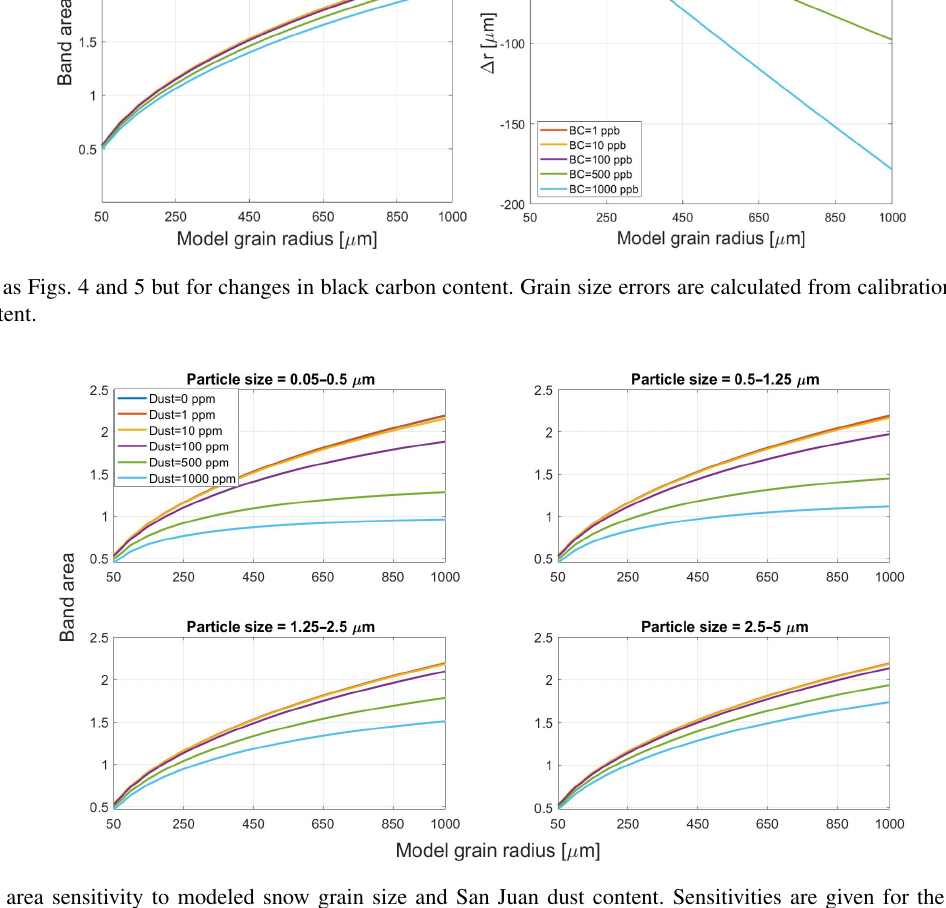
Figure 7. Band area sensitivity to modeled snow grain size and San Juan dust content. Sensitivities are given for the four particle size